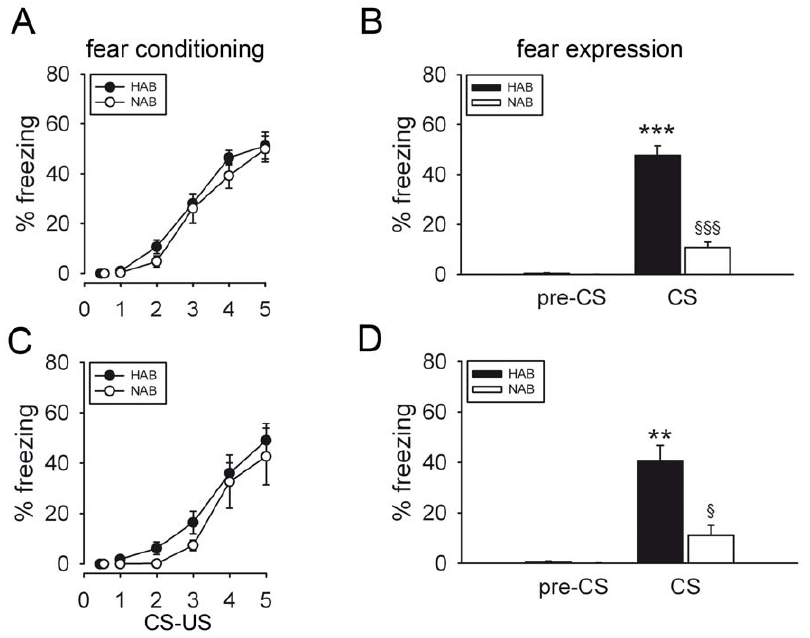
Figure 2. Cued conditioned fear in HAB and NAB mice during the light (A, B) and dark (C, D) phases of the circadian cycle. Both lines showed the same increasing conditioned responses to the CS-US presentations, as indicated by freezing levels during CS presentation (A, C). In contrast, compared with NAB mice, HAB mice showed more pronounced freezing levels in response to the CS only during fear expression performed 24 h later (B, D). Note that freezing levels prior CS presentation (pre-CS) were negligible indicating that there was no contextual fear component (B, D). Data are presented as means 6 SEM. n =7–11 per line. ** p , 0.01, *** p , 0.001 HAB vs. NAB; 1 p , 0.05, 111 p , 0.001 fear expression vs. last CS-US pairing.